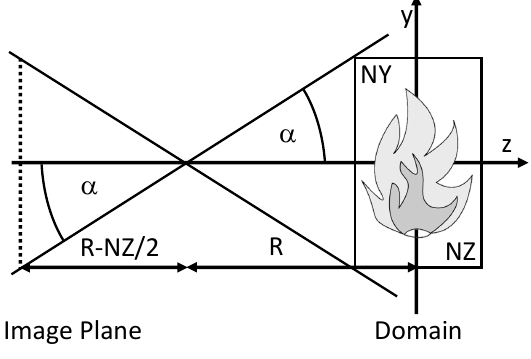
Figure 2. Ray-tracing